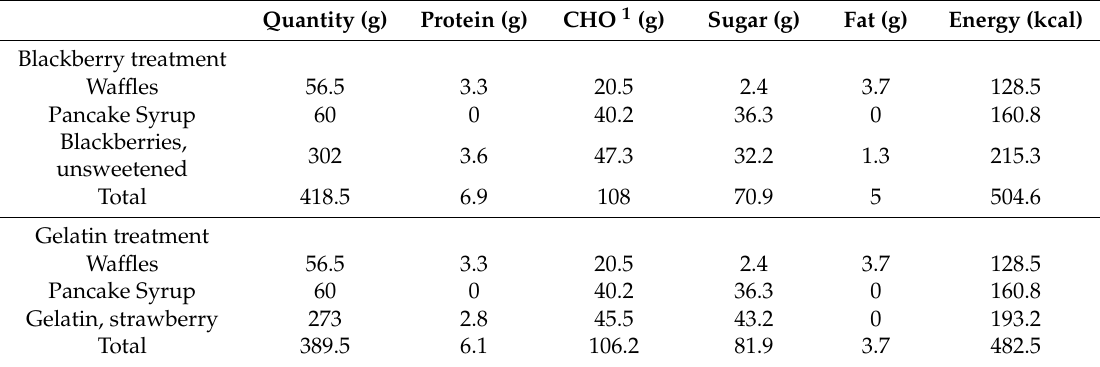
Table 2. Macronutrient content of components of the meal-based glucose tolerance test provided at the end of the 7-day controlled feeding